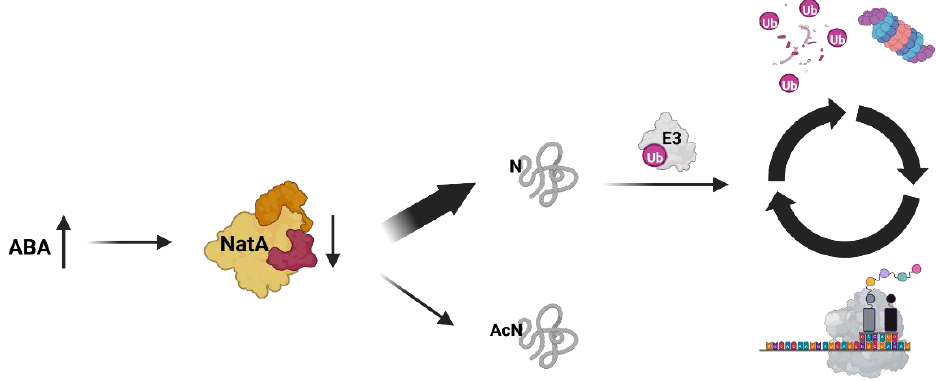
Figure 5. Hypothesis of phytohormone-regulated proteome destabilization via depletion of NatA in A. thaliana . In the presence of abscisic acid, NatA is depleted [20]. In consequence, less proteins are N-terminally acetylated. NatA substrates with free N-termini are recognized by up-to-date unknown E3 ubiquitin ligases, which target these proteins for degradation via the proteasome. Altogether, the depletion of NatA activity results in an increased overall protein turnover, as the degraded NatA substrates are replaced by newly synthesized proteins.